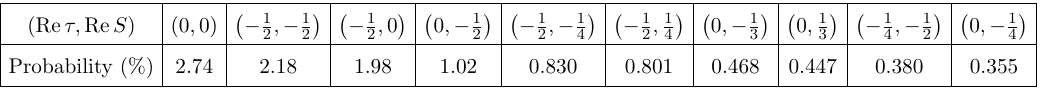
Table 11 . Probabilities of the stable vacua as functions of (Re (cid:28); Re S ) in the descending order of the probability for N max = 10. (cid:13)ux